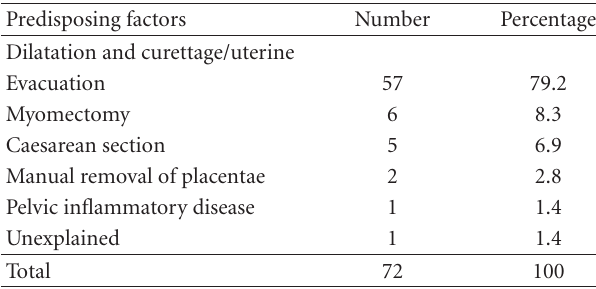
Table 5: Predisposing factors in 72 cases of